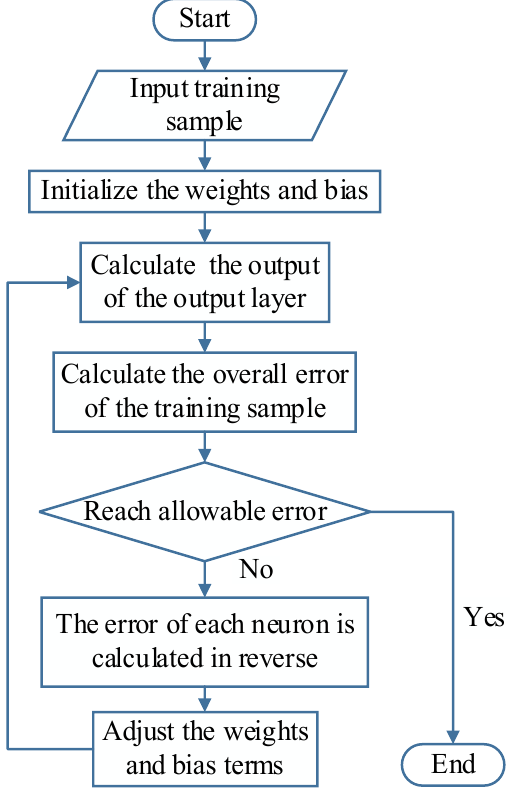
Figure 5. BP neural network training process.